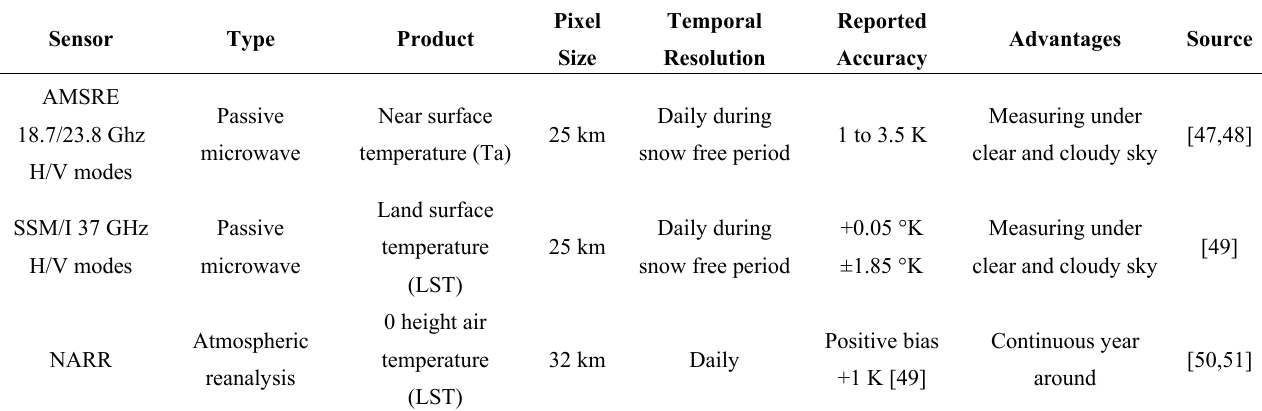
Table 3. Summary of coarse resolution